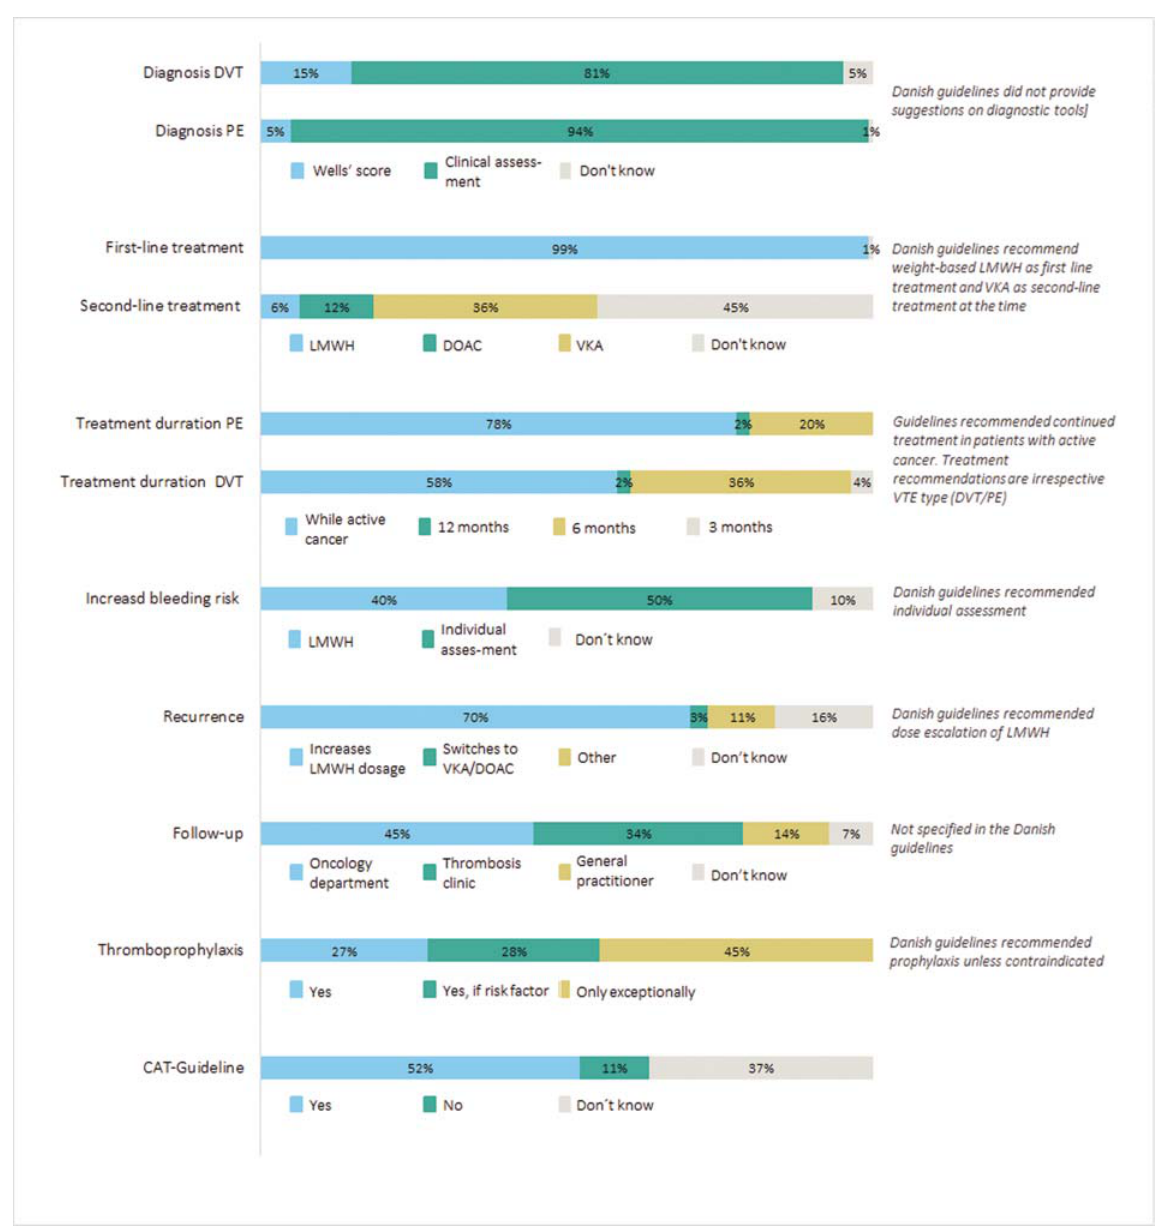
Fig. 1 Management of cancer associated thrombosis in Danish oncology departments. CAT, cancer associated thrombosis; DOAC, direct oral anticoagulant; DVT, deep vein thrombosis; LMWH, low-molecular-weight heparin; PE, pulmonary embolism; VKA, vitamin K